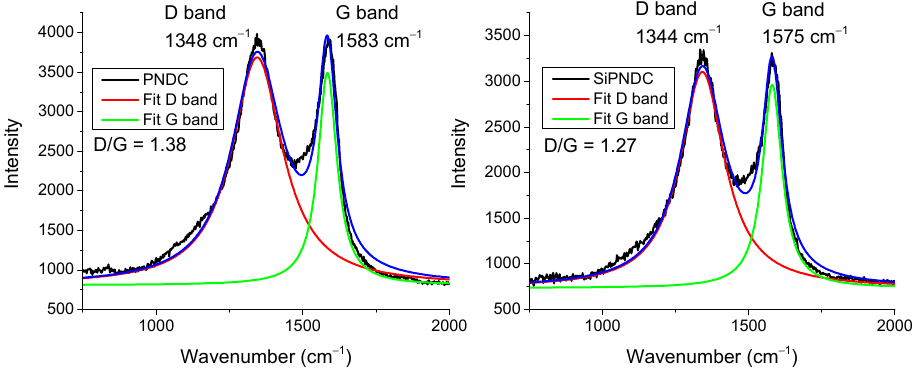
Figure 4. Raman spectra of PNDC and SiPNDC.